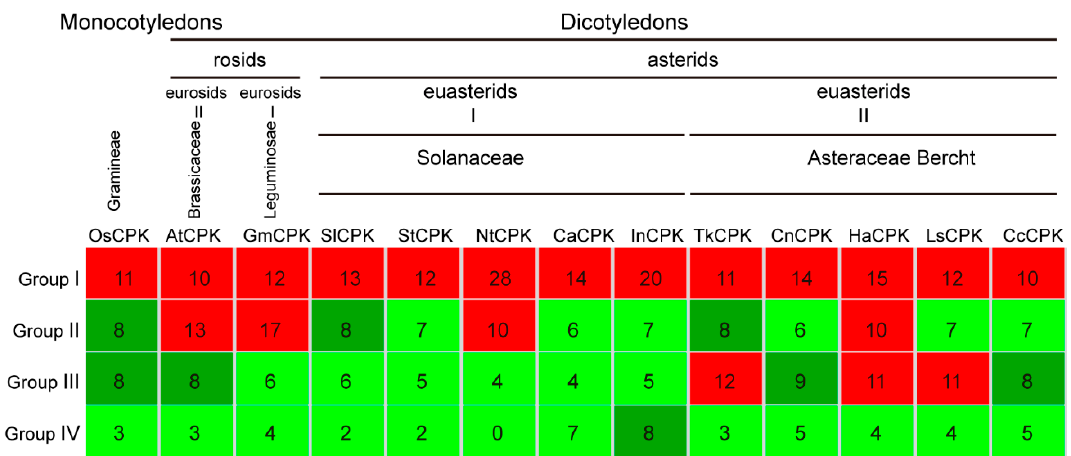
Figure 3. Duplication and syntenic analysis of CPKs in Asteraceae plants and S. lycopersicum . Chromosomes and sca ff olds are shown in di ff erent colors and all CPK gene locations are indicated. The syntenic relationship of CPKs in four di ff erent groups are connected by di ff erent colored lines: group I (yellow), Group II (red), group III (magenta) and Group IV (blue).